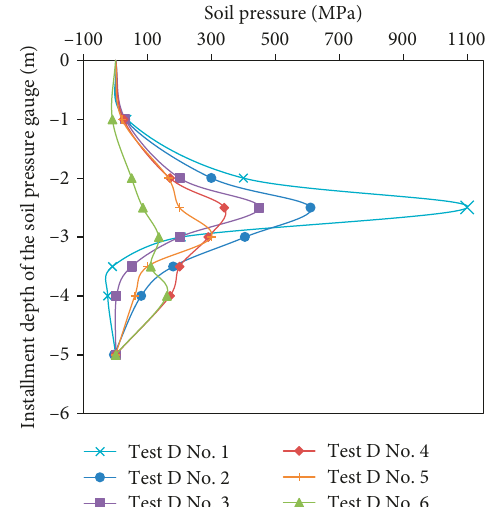
Figure 12: Variation of soil pressure with installment depth for Test D.